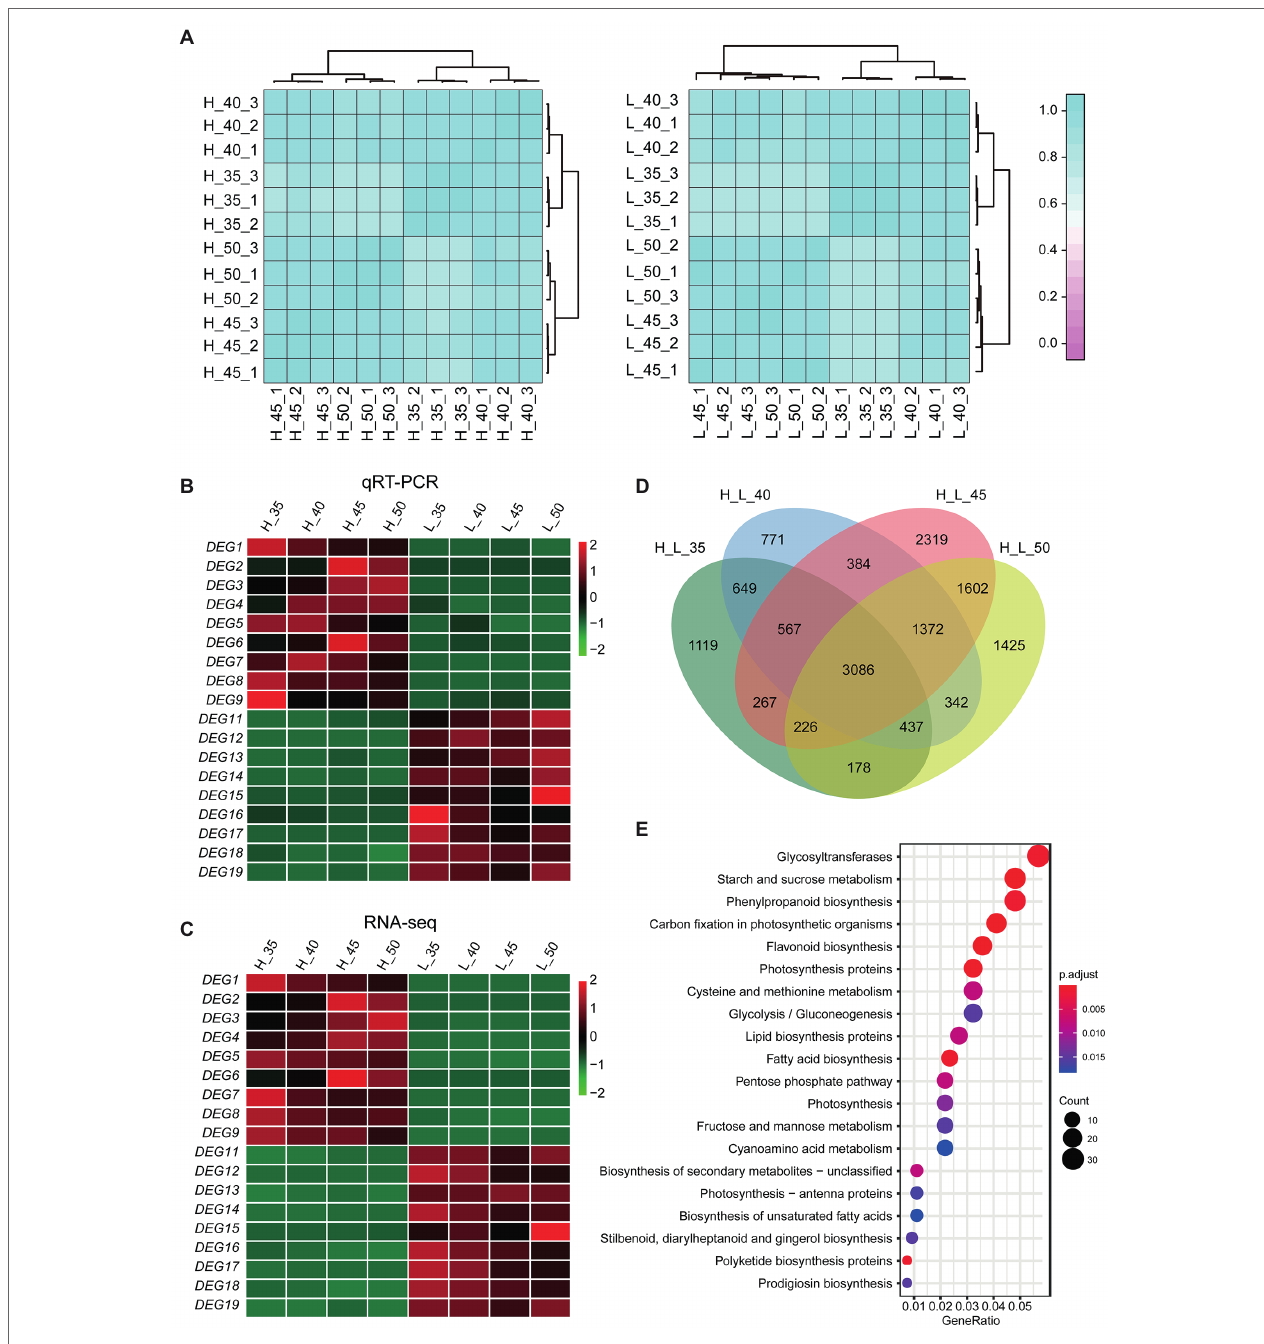
FIGURE 5 | RNA-seq analysis and Kyoto Encyclopedia of Genes and Genomes (KEGG) enrichment analysis of differentially expressed genes (DEGs). (A) Spearman correlation plot in developed seeds of GRD328 (high seed oil content) and GRG2462 (low seed oil content). (B,C) Heatmap represented that the expression levels of the DEGs based on the RNA-seq was verified by quantitative real-time PCR (qRT-PCR). DEGs 1–9 were upregulated in GRD328, and DEGs 11–19 were downregulated in GRD328. The bars represented the normalized transformed counts of qRT-PCR values (B) and FPKM (C) , respectively. (D) The statistical analysis of DEGs in developed seeds between two parents. (E) KEGG enrichment analysis of